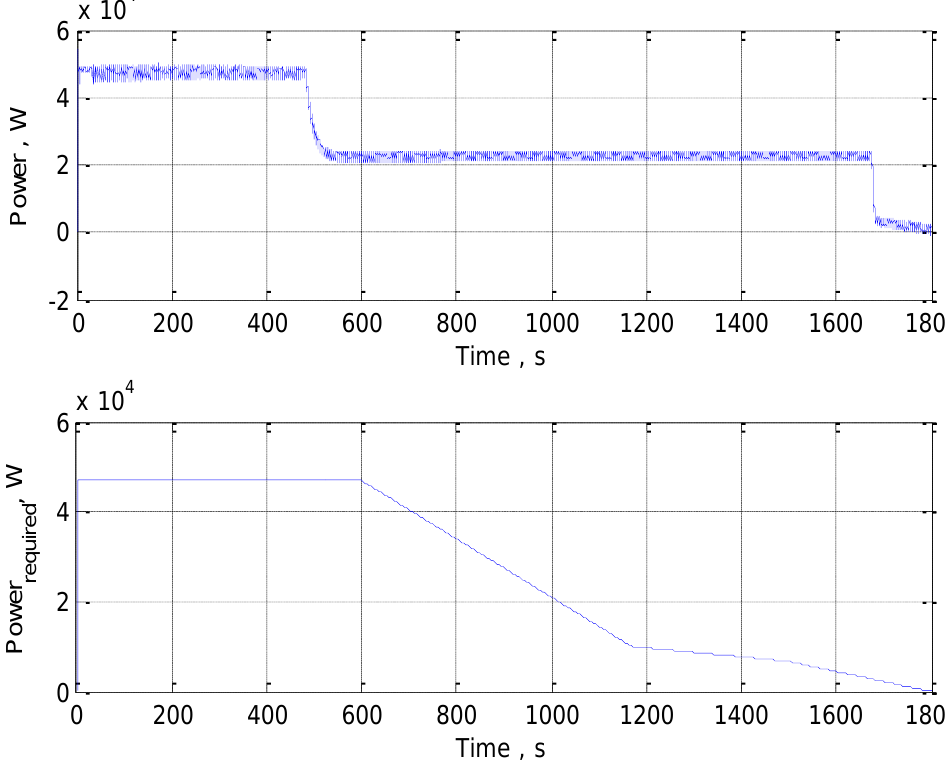
Figure 7. Realized and reference power at C = 300 F.